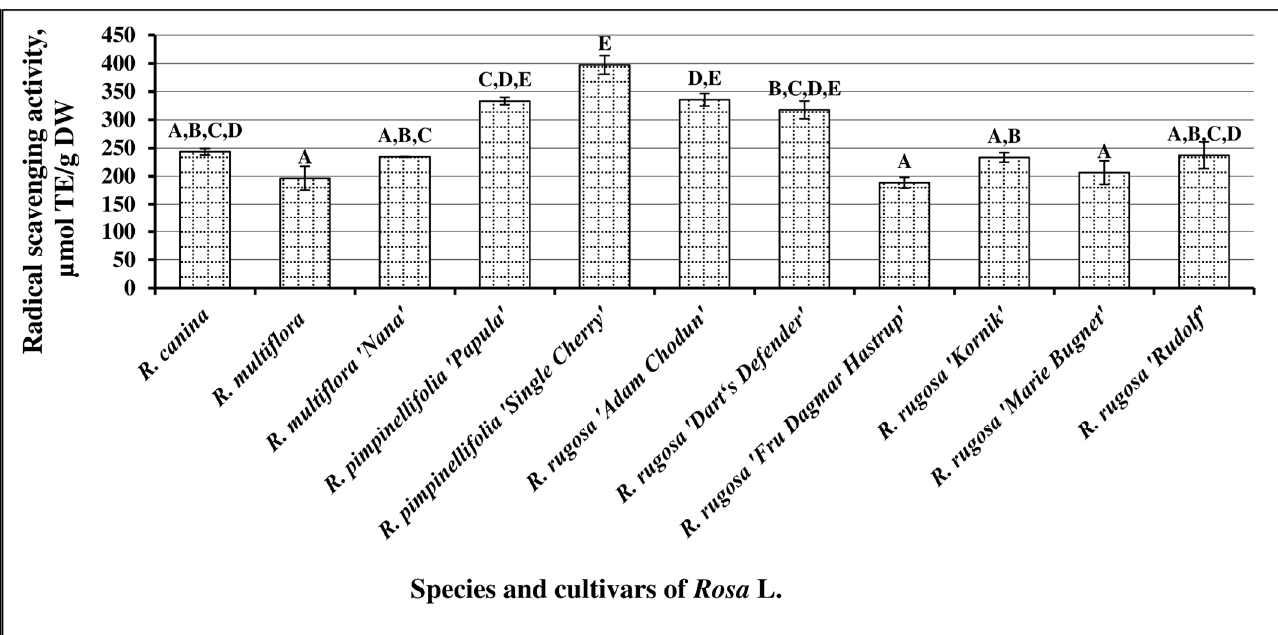
Figure 7. Variability of the radical scavenging activity of Rosa L. fruit-sample extracts in vitro; different letters indicate statistically significant ( p < 0.05) differences between the samples.